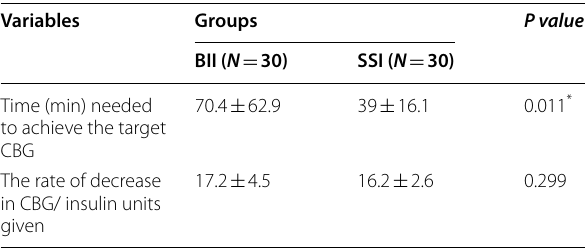
Data are presented as mean SD. P value > 0.05 is statistically non-significant ± *indicates statistical significance. BII Bolus-insulin infusion group, SSI Sliding scale of insulin group, CBG Capillary blood glucose